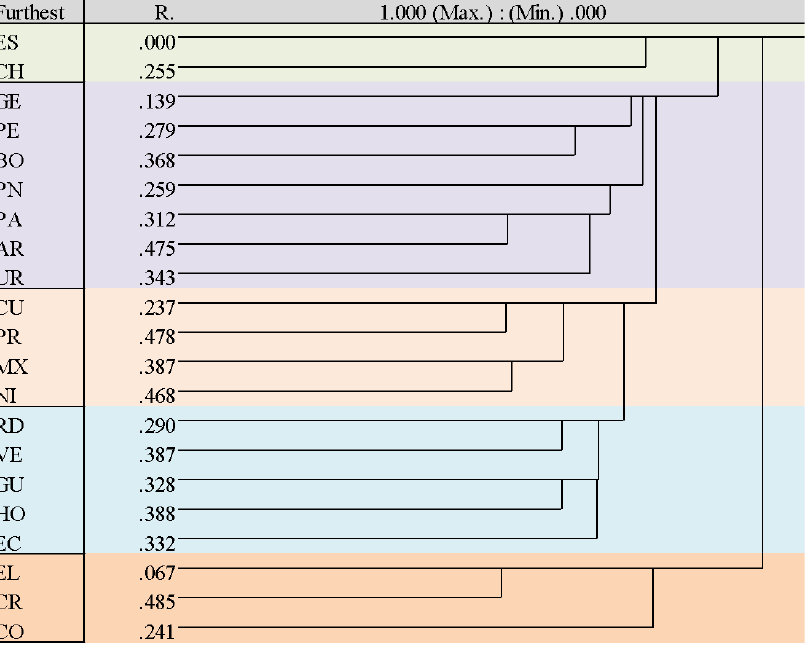
Figure 1. Cluster analysis (mean distance method) of Spanish-speaking countries in the Varilex-R database. Country